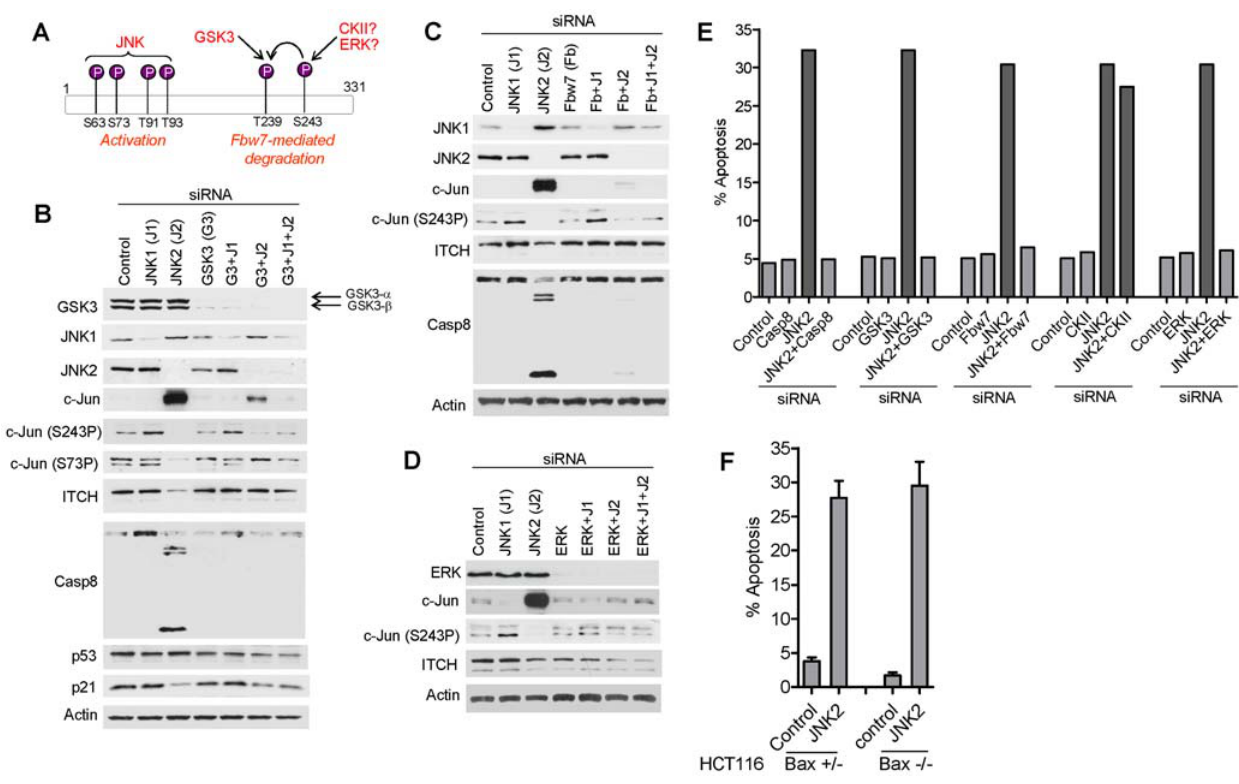
Figure 4. GSK3, ERK and Fbw7 are essential basal pro-apoptotic mediators following JNK2 silencing but are without apparent effect upon their stress-associated substrate c-Jun. (A) Schematic showing sites of phosphorylation of c-Jun by JNK, GSK-3 and ERK, and their respective functional consequences. Note that S243P is a pre-requisite of T239 phosphorylation (indicated by curved arrow). (B) Immunoblots showing effects of JNK1, JNK2 and GSK3 silencing, alone and in combinations, on a panel of HCT116 cellular proteins. (C) and (D) Immunoblots following combinatorial silencing of JNK1 and JNK2 with Fbw7 and ERK. (E) Essential pro-apoptotic intermediates determined by co-silencing with JNK2. (F) Apoptosis following JNK2 silencing under basal conditions is independent of Bax as evidenced by Bax + / 2 and Bax 2 / 2 HCT116 isogenic